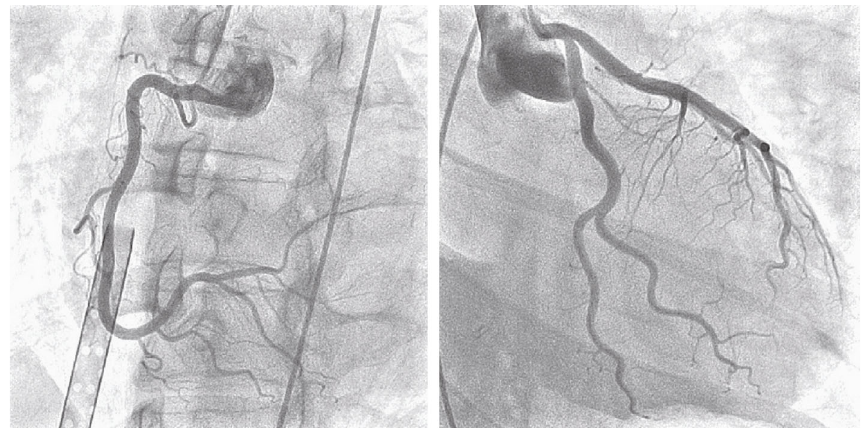
Figure 3: Coronary angiography showing no signi fi cant stenosis.